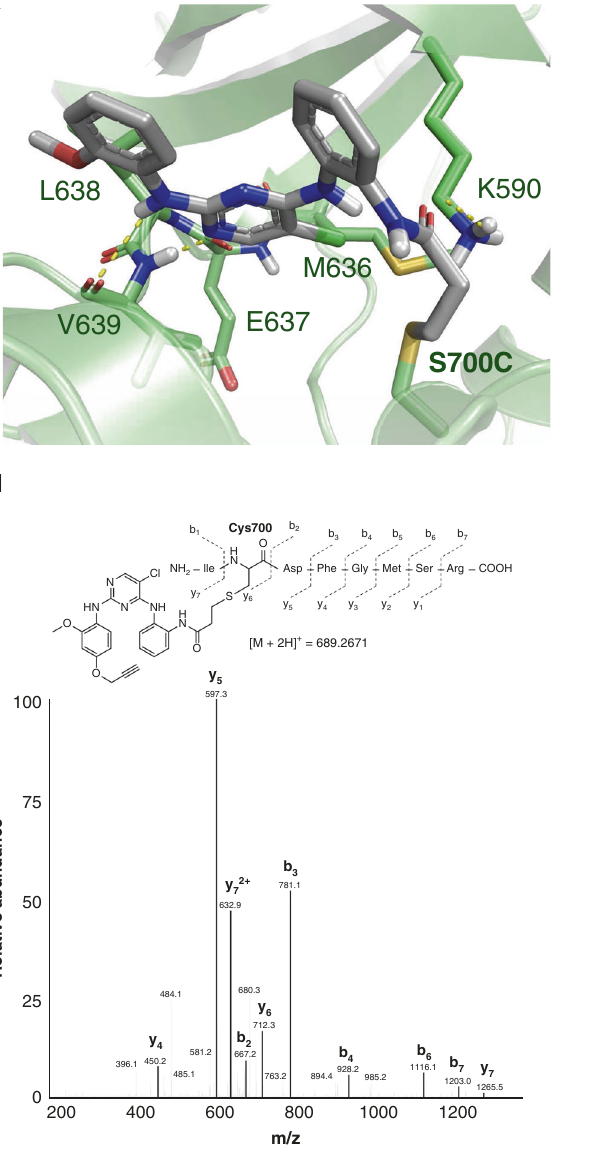
Fig. 3 FES S700C is selectively and covalently inhibited by WEL028. a Proposed covalent binding mode of compound 4 to Cys700 in crystal structure of FES (PDB code: 4e93). b In vitro inhibition pro fi le of FES WT and FES S700C by WEL028 (TR-FRET assay, n = 3). c Inhibition pro fi le of WEL028 (100 nM) on FES WT and FES S700C on peptide substrates (PamChip ® microarray, normalized to vehicle-treated control, n = 3). Scale shows residual activity from minimum (0%, red) to maximum (100%, gray). d MS/MS-based identi fi cation of WEL028 covalently bound to Cys700. Precursor ion ( m / z [M + 2H] 2 + = 689.2671) was fragmented and signature ions are shown. Precursor ion was not observed in vehicle-treated control. e In vitro selectivity pro fi le of WEL028 (1 µ M, 1 h preincubation) on 380 recombinant kinases, visualized as waterfall plot (each data point is an individual kinase; n = 2). Data represent means ± SEM. Source data are provided as a Source Data fi